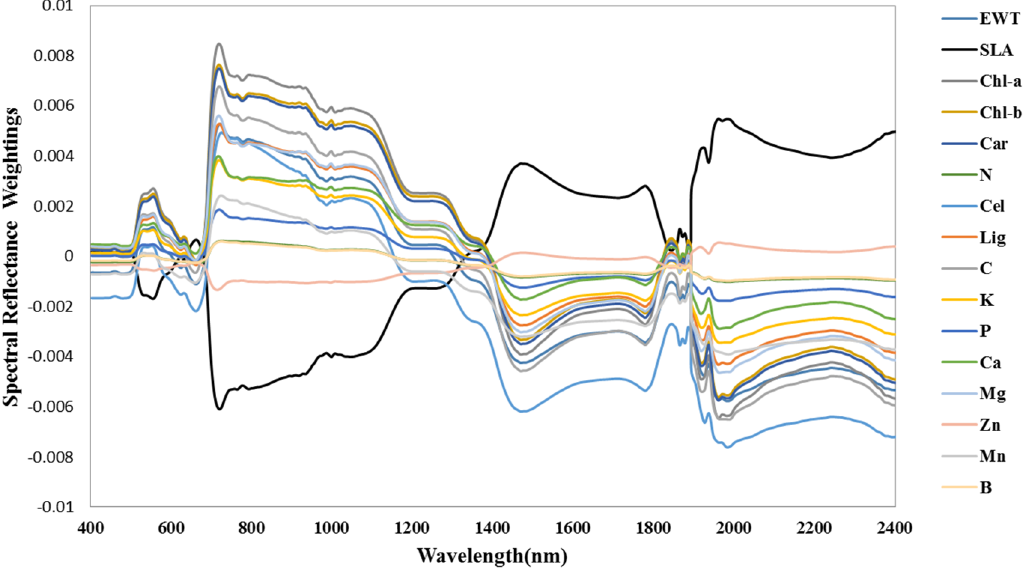
Figure 6. Partial least squares regression (PLSR) reflectance weighting factors for fifteen leaf chemical properties and SLA.